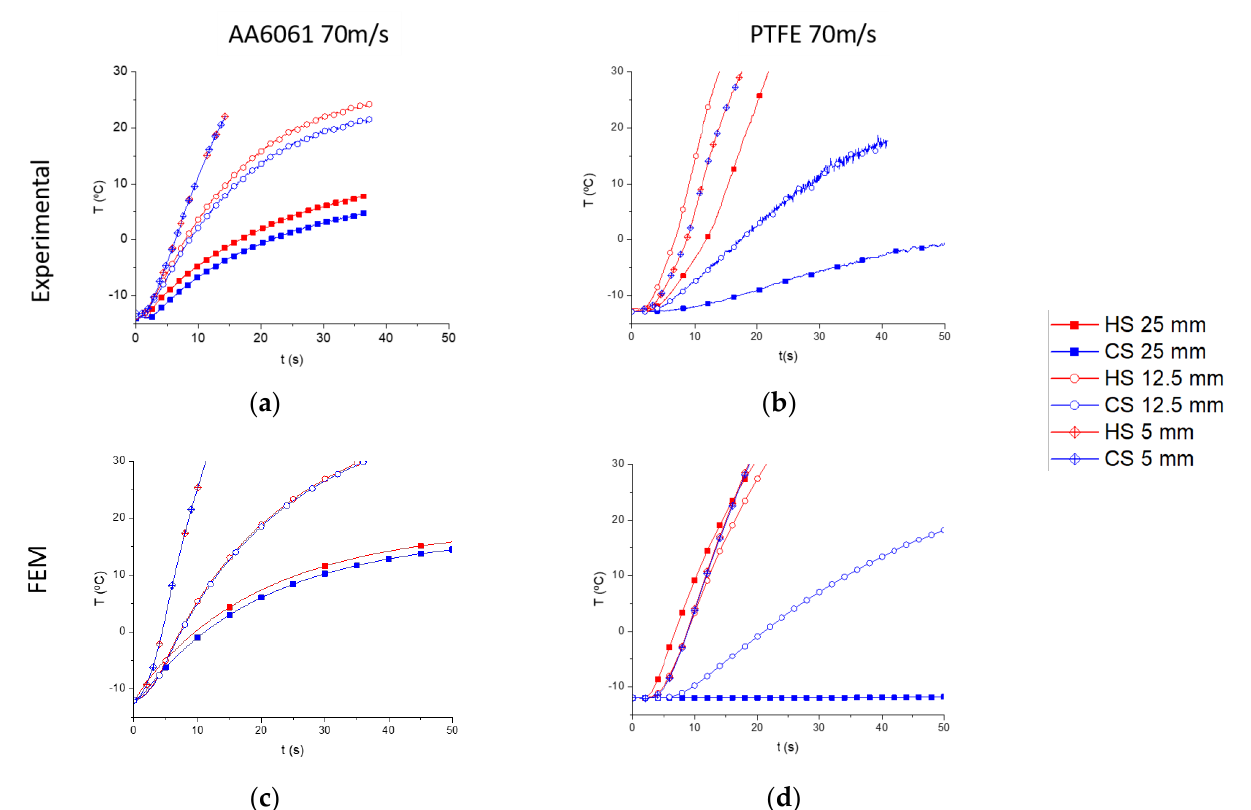
Figure 17. HS and CS temperature on different-sized samples under the 70 m/s condition. ( a ) AA6061. ( b ) PTFE. ( c ) Modeled AA6061 ( d ) Modelled PTFE.